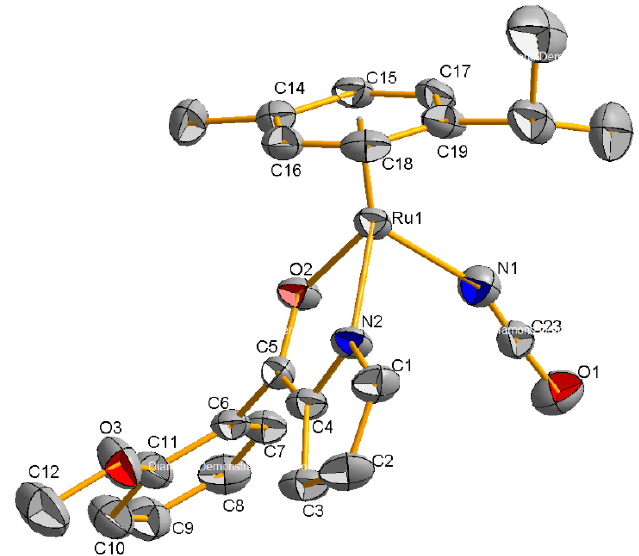
Figure 3. The molecular geometry of Compound 4 . The thermal ellipsoids were drawn at 50% probability and all the hydrogen atoms were omitted for clarity.